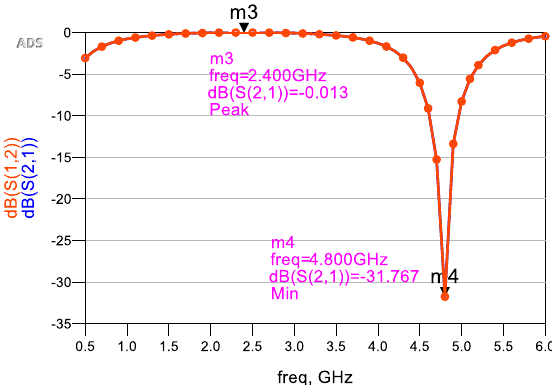
Fig. 6. S-parameters results of the proposed biasing network (S 12 and S 21